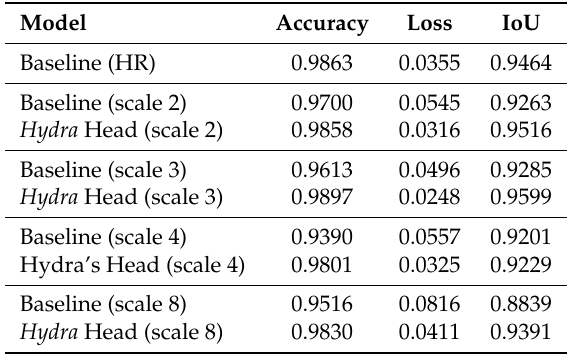
Table 3. Performance of Hydra segmentation head and baseline model on Montgomery